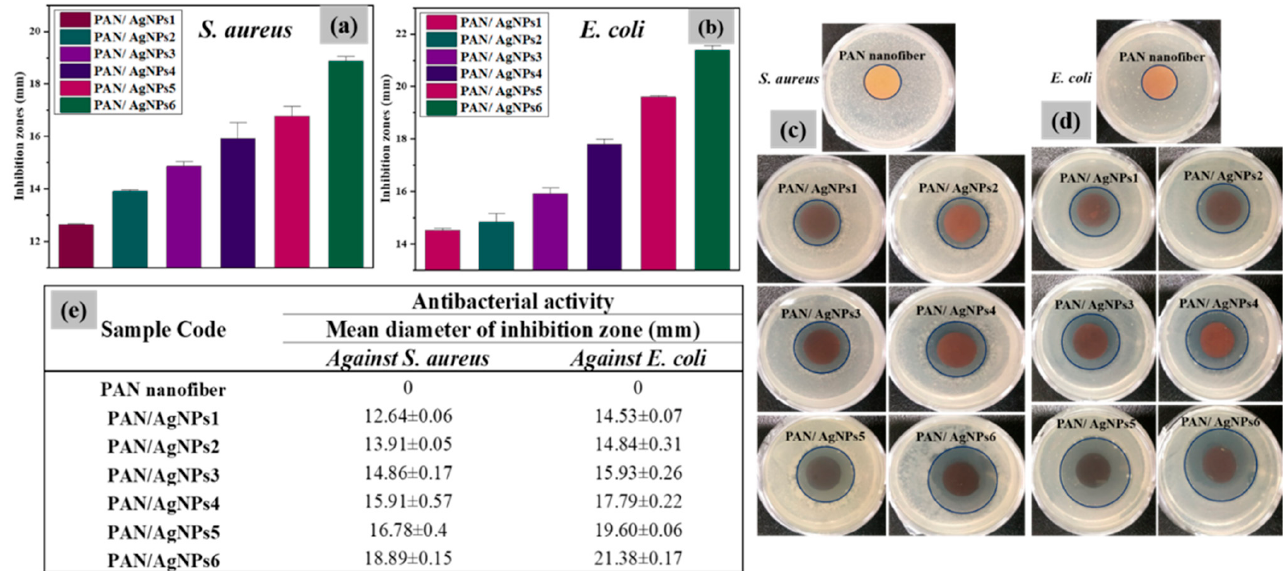
Figure 9. Diameters of zones of inhibition by disk diffusion test of PAN/AgNPs with standard deviations against S. aureus ( a ) and E. coli ( b ); discs showing antibacterial activity against S. aureus ( c ) and E. coli ( d ); Numerical values showing mean diameters of inhibition zones of PAN and PAN/AgNPs against S. aureus and E. coli ( e ).